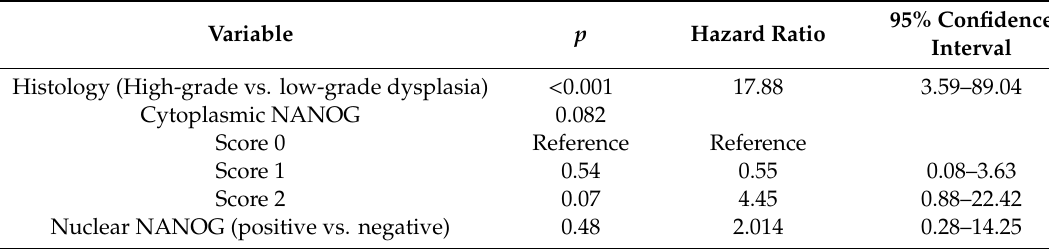
Nuclear NANOG (positive vs.